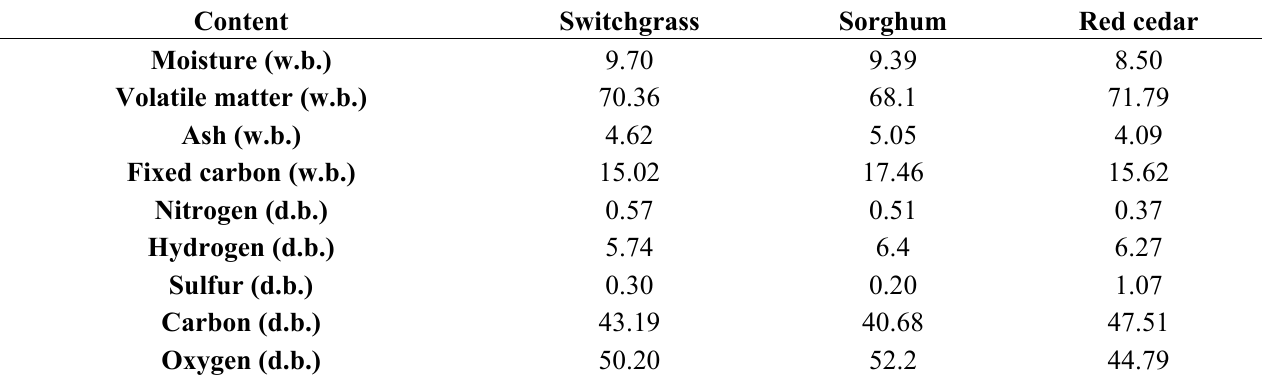
Table 1. Proximate analysis and ultimate analysis of feedstocks, wt%. Content Switchgrass